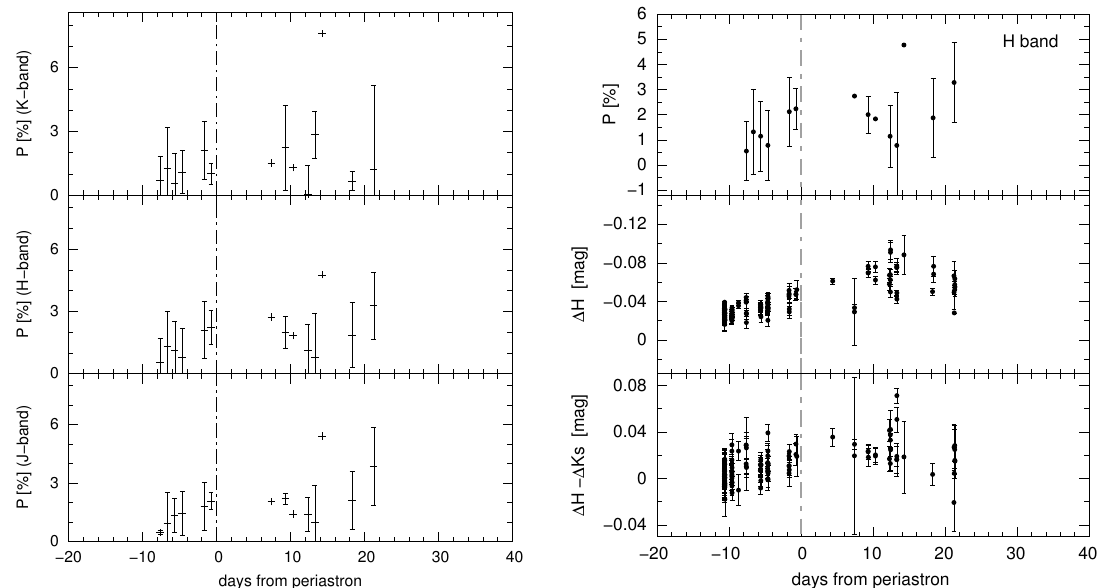
Figure 1. Linear polarization of PSR B1259 − 63 in the near-infrared band with IRSF/SIRPOL at the time of the 2010 periastron. In the left panel, the data in the Ks , H , and J bands are plotted (from the top to the bottom). The data for each night are averaged, and the error bar shows the standard deviation. The data without the error bar indicates that only one or two sets of data were taken on that night. In the right panel, the polarization degree in the H band is compared with variations of H magnitude and ( H − Ks ) color. Please note that the data around the periastron (from − 25 to + 40 days) are shown in these